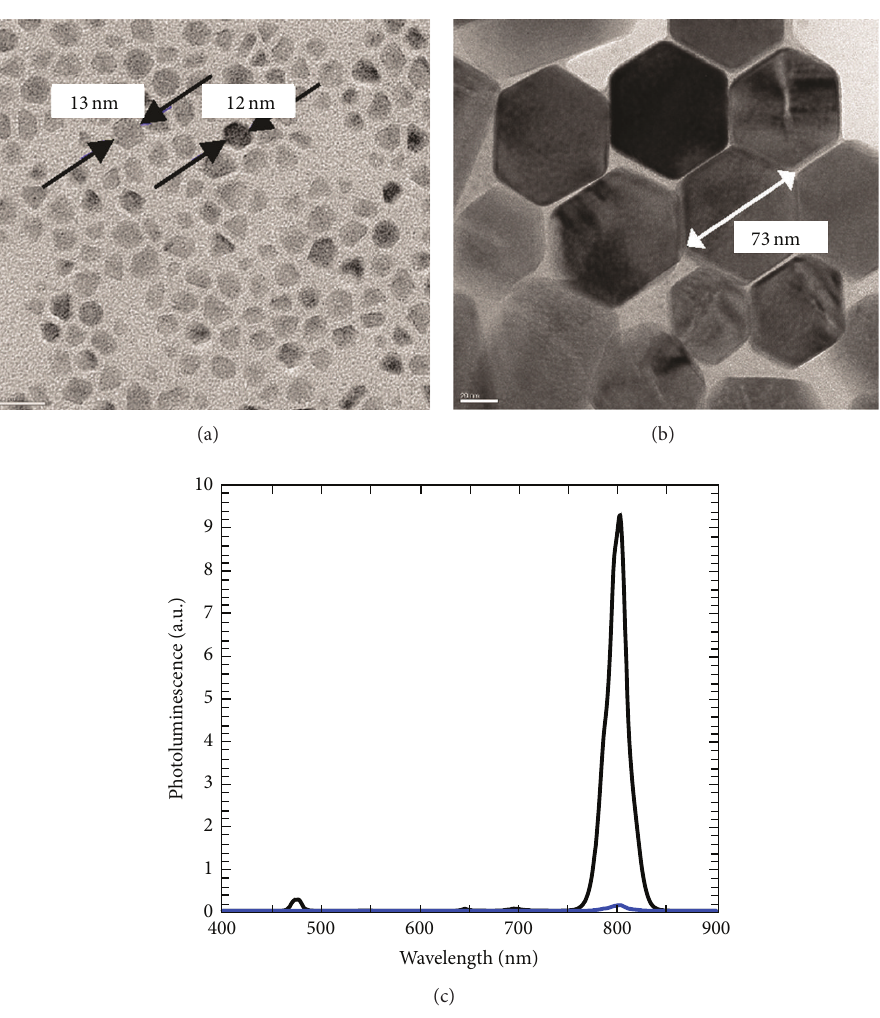
Figure1:HR-TEMimagesandrelativeupconversionefficiencyillustratethestrongdependenceonthereactiontemperaturefortheproperties of NaY 0.747 Yb 0.25 Tm 0.003 F 4 nanoparticles (a). At 300 ∘ C, small particles (12nm or less) are formed with poorly defined crystal structure. At 315 ∘ C, Ostwald ripening results in large hexagonal phase particles with high lattice uniformity (b). In both images, the scale bar equals 20 nm. Under identical measurement conditions, the upconversion intensity for the 315 ∘ C-processed particles (black curve) is more than 10 times stronger than that from the 300 ∘ C-processed material (blue